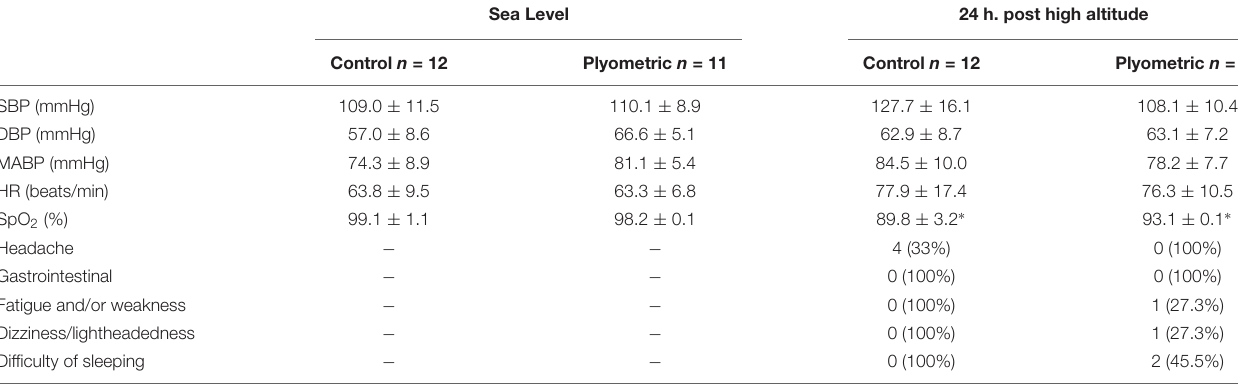
FIGURE 1 | Schematic representation of the study experimental design. RSI30, 30 cm drop jump reactive strength index; RE, running economy; VO 2 max, maximal oxygen uptake. TABLE 1 | Effect of high altitude (3,270 m above sea level) on physiological parameters and Lake Louise acute mountain sickness survey. Sea Level 24 h. post high